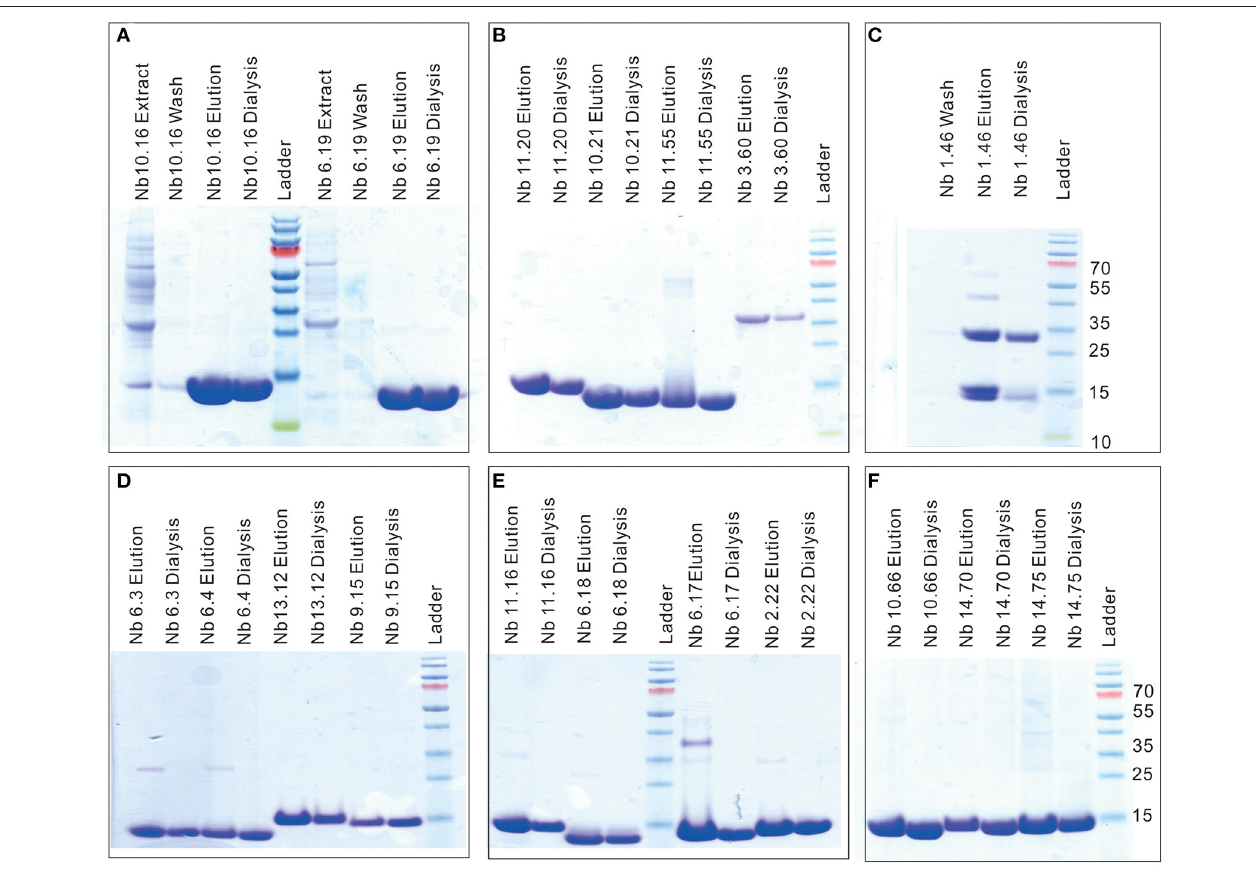
FIGURE 3 | SDS-PAGE to confirm the purity and size of Clec4F nanobodies. Ten percentage SDS-PAGE revealed the presence of (A) Nb10.16, Nb6.19 (B) Nb11.20, Nb10.21, Nb11.55, Nb3.60 (C) Nb1.46 (D) Nb6.3, Nb6.4, Nb13.12, Nb9.15 (E) Nb11.16, Nb6.18, Nb6.17, Nb2.22 (F) Nb10.66, Nb14.70 and Nb14.75, in (periplasmic) extract, wash flow through (10mM imidazole-PBS), elution buffer (500mM imidazole-PBS) and Nb after dialysis (PBS). It showed high purity and a characteristic Nb size of around 14 kD; Nb1.46 and Nb3.60 show dimerized material. M lane: relative molecular mass marker